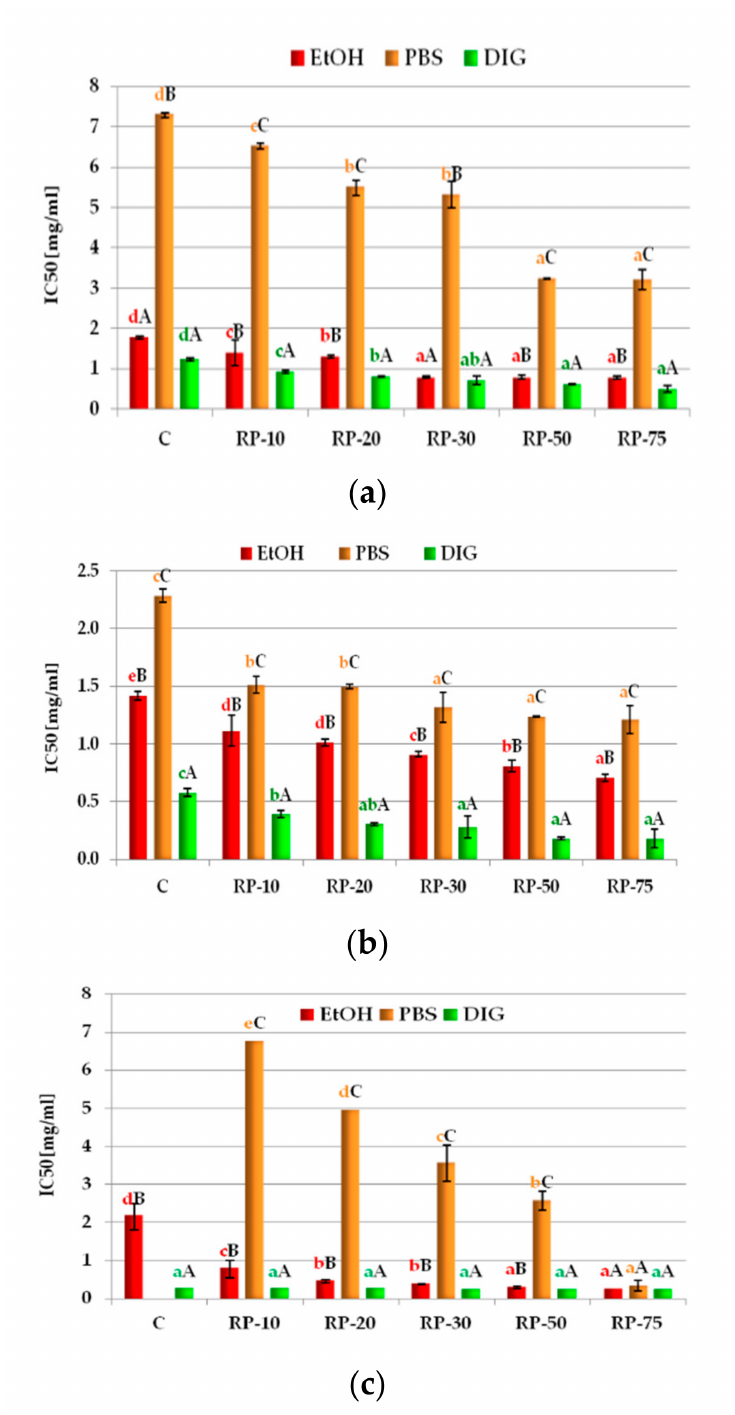
Figure 4. Xanthine oxidase -XO ( a ), lipoxygenase—LOX ( b ), and cyclooxygenase-2—COX-2 ( c ) in- hibitory activity of EtOH, PBS, and DIG extracts from control and fortified wafers. C—wafers without raspberry pomace (control), RP-10–RP-75—wafers with 10% to 75% raspberry pomace addition, respectively. All values are mean ± standard deviation for triplicate experiments. Means with differ- ent small letters show significant differences between samples with different % of supplementation (red—EtOH, orange—PBS, green—DIG) at p ≤ 0.05. Values denoted by different capital letters are statistically different within the same sample but between the different types of extract ( p <